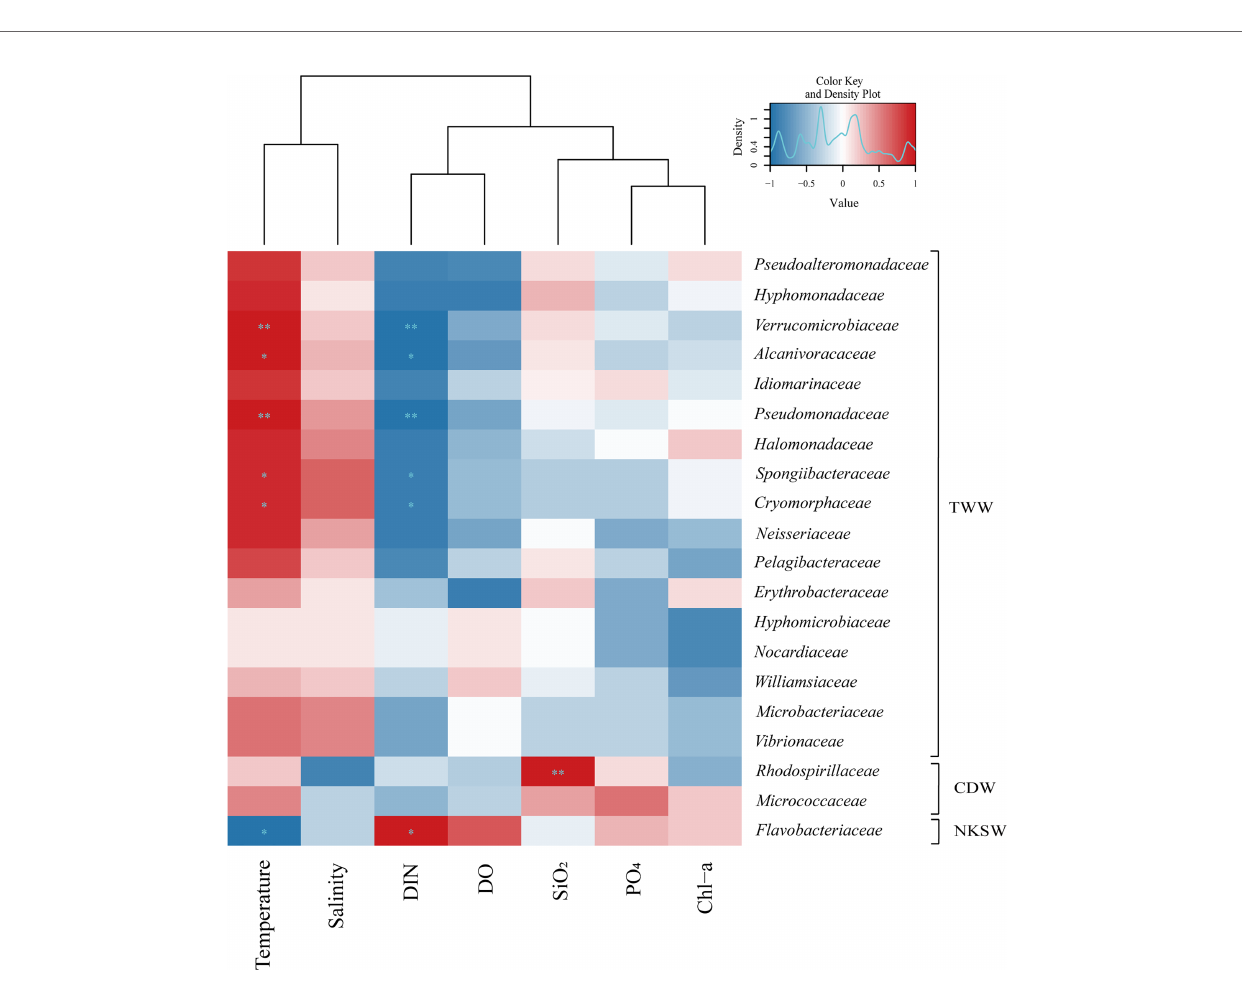
FIGURE 4 | The 20 genera in family level of bacteria which showed signi fi cant differences in relative abundance within three groups (i.e., TWW, CDW, and NKSW). Hierarchical heatmap using Spearman ’ s rank order correlation coef fi cient showed correlation between the relative abundance of bacteria at the 37 genera family level and physical and biogeochemical factors of temperature, salinity, PO 4 , SiO 2 , DO, DIN, and Chl-a concentration in summer. The variations of 20 genera family level relative abundance showed strong correlation to hydrographic characteristics of each water masses. The symbols of * and ** indicate p value less than 0.05 and 0.01,